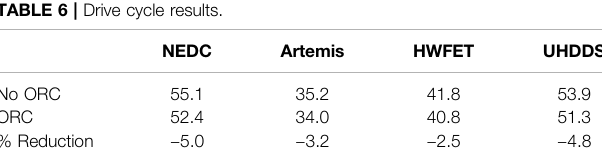
TABLE 6 | Drive cycle